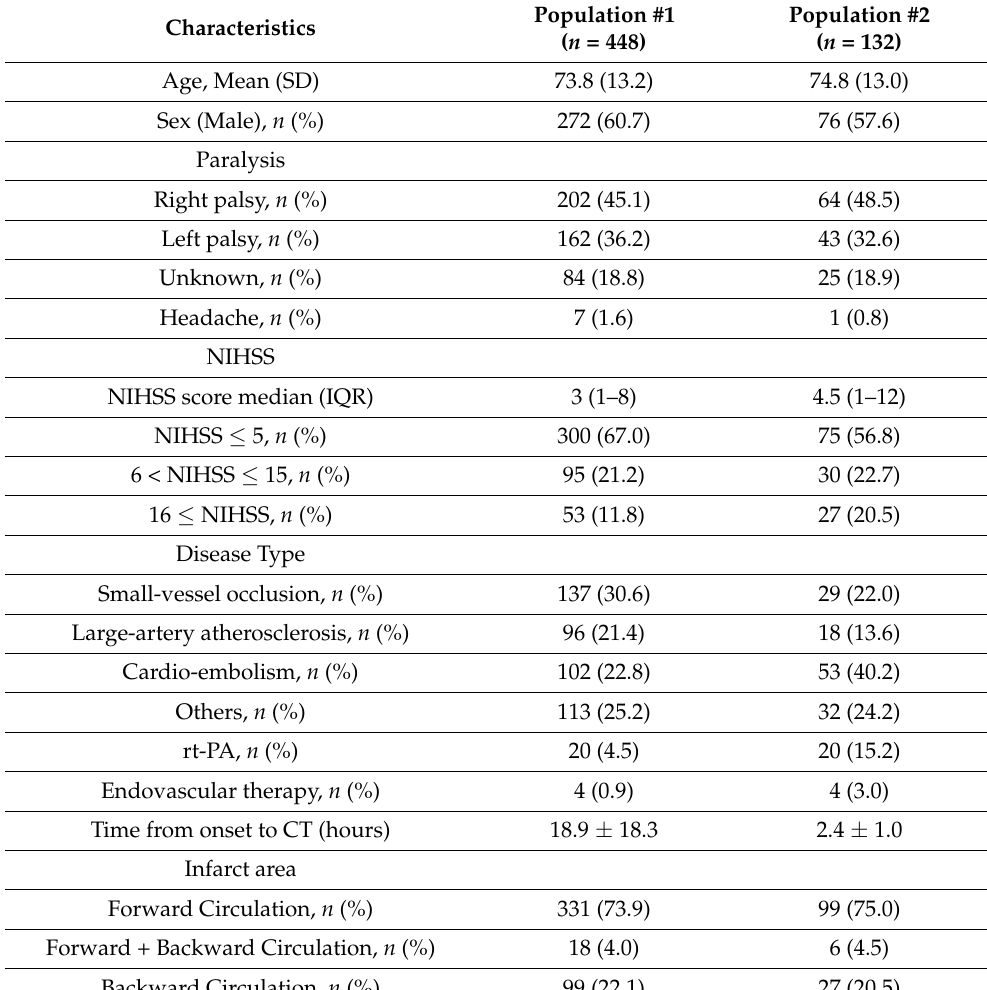
Table 1. Characteristics of the